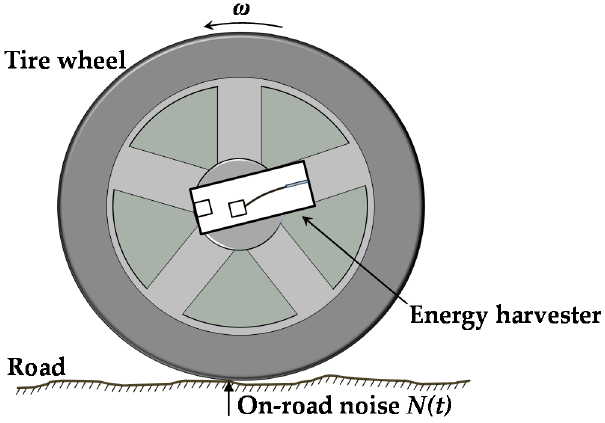
Figure 1. Illustration of the energy harvester attached to the center of a wheel.